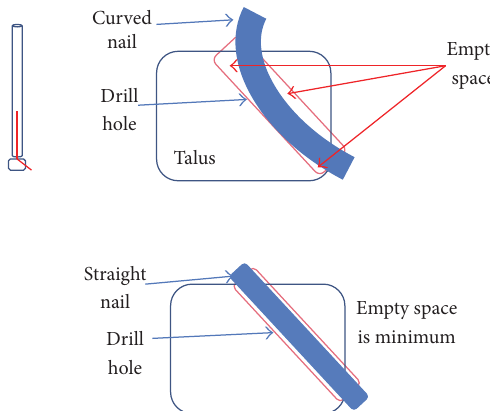
Figure 7: The more pronounced curvature of the talus segment due to the smaller radius of curvature requires a larger diameter drill hole for insertion, thus removing more bone compared to a straight design.